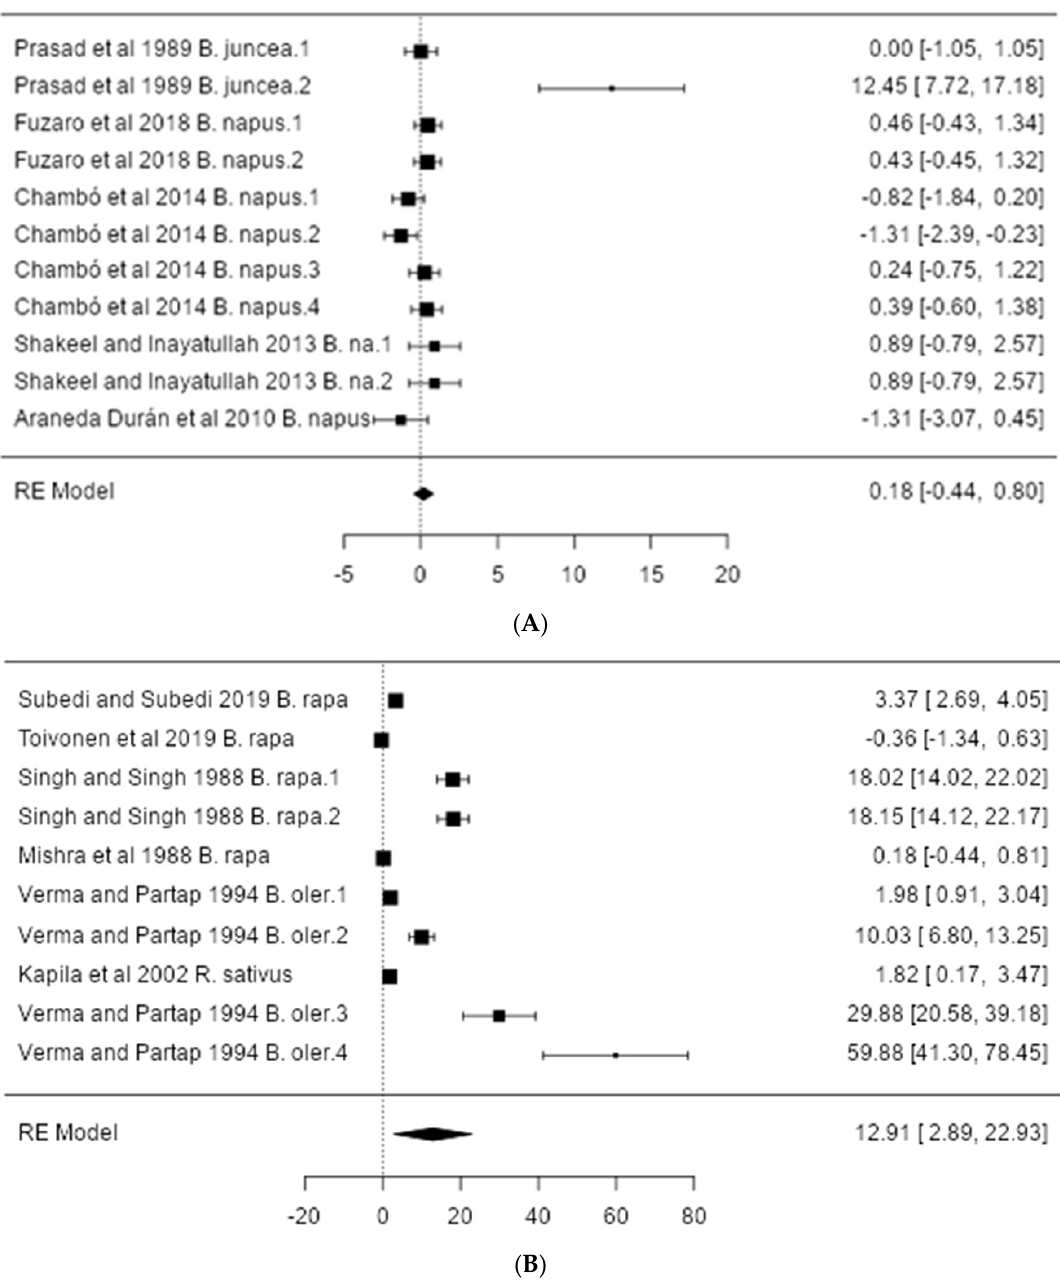
Figure 4. Forest plot of meta-analysis for the effect of insect pollination on the weight of seeds in self-compatible ( A ) and self-incompatible Brassicaceae crops ( B ). In some cases B. napus and B. oleracea have been abbreviated as B. na. and B. oler., respectively, to avoid overlapping with error bars and squares.